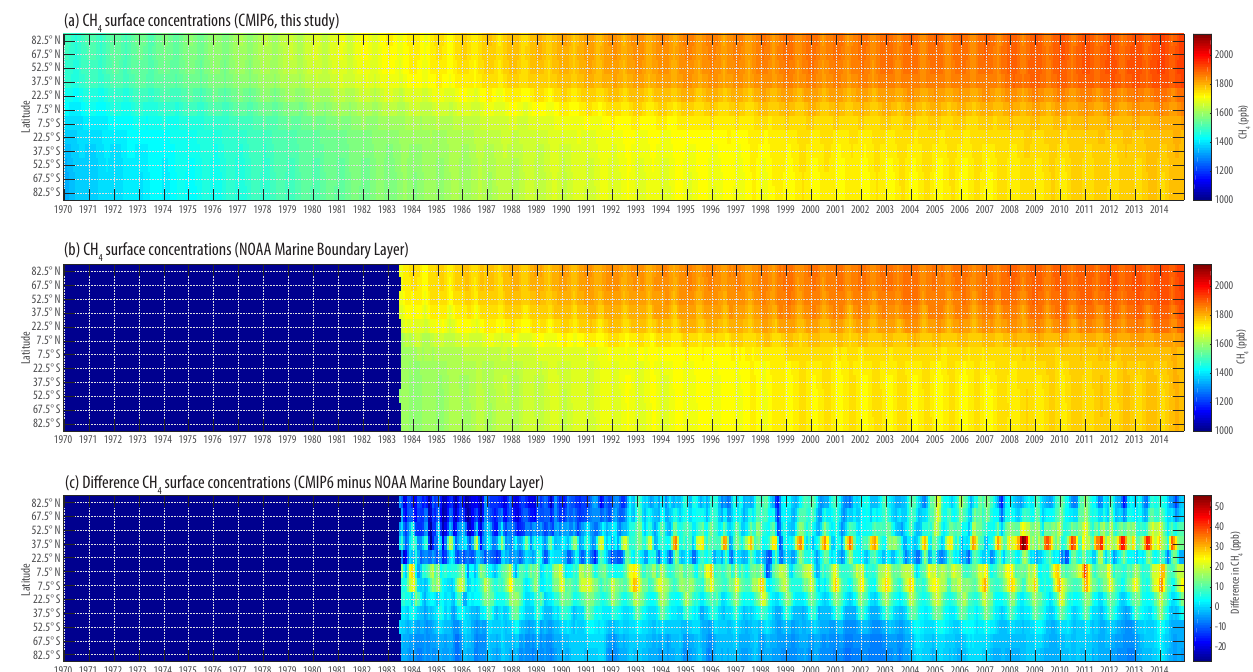
1970 1971 1972 1973 1974 1975 1976 1977 1978 1979 1980 1981 1982 1983 1984 1985 1986 1987 1988 1989 1990 1991 1992 1993 1994 1995 1996 1997 1998 1999 2000 2001 2002 2003 2004 2005 2006 2007 2008 2009 2010 2011 2012 2013 2014